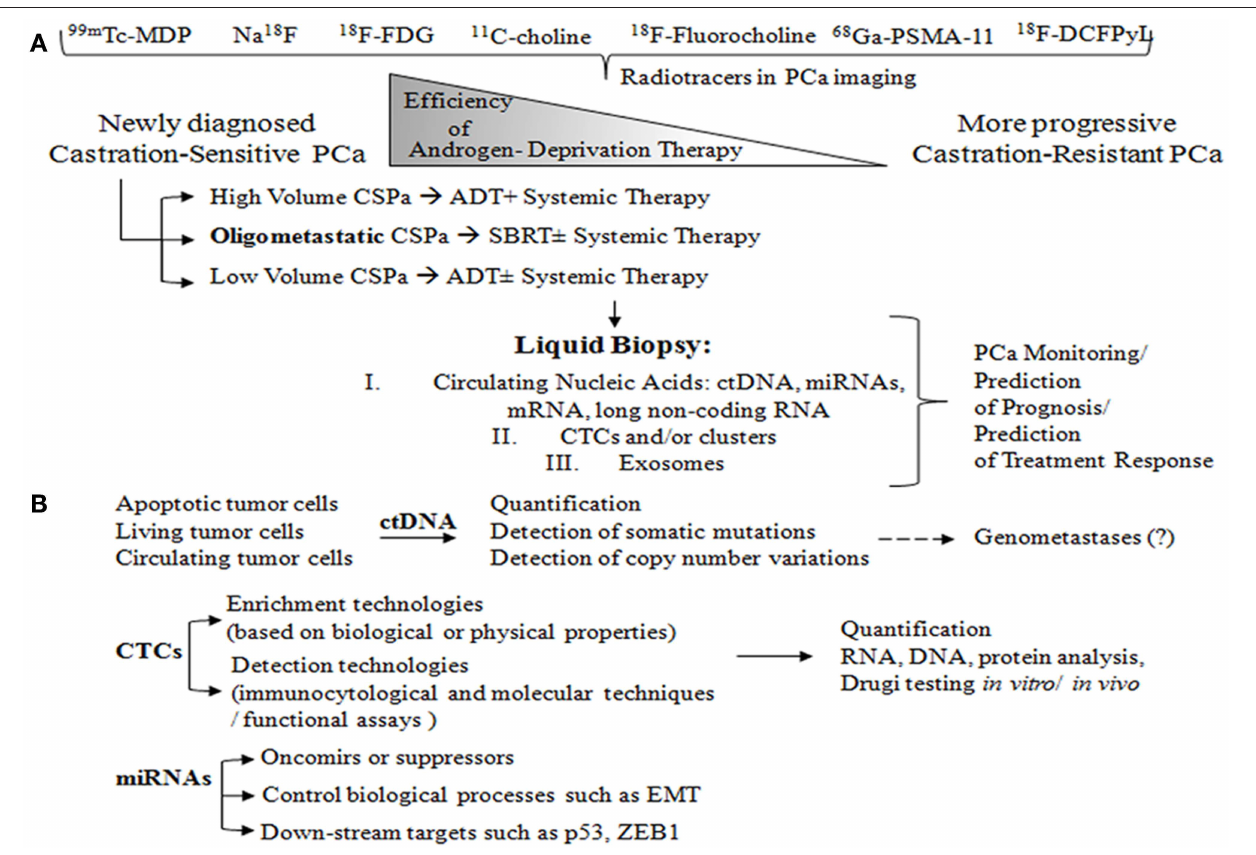
FIGURE 1 | (A) Radiotracers commonly used for imaging in patients with oligometastatic PCa: 99m Tc-MDP and Na 18 F, for imaging bones with altered osteogenic activity; 18 F-FDG, to evaluate abnormal glucose metabolism; 11 C-choline and 18 F-Fluorocholine, both derivatives of choline, which serve to detect metabolically active cells; 68 Ga-PSMA-11 and 18 F-DCFPyL, small molecule inhibitors of PSMA. PCa is characterized by the group of heterogeneous cells that are generally hormone-sensitive but can become castration-resistant. Administration of androgen-deprivation therapy (ADT) promotes the growth of castration-resistant cells, ultimately leading to the formation of castration-resistant PCa. Metastatic volume and distribution influence the treatment decision in metastatic castration-sensitive PCa (CSPC). High volume CSPC is defined as PCa with the presence of visceral metastases or ≥ 4 bone metastases. Oligometastatic PCa is characterized by 3–5 metastatic lesions. Liquid biopsy is a highly promising, non-invasive approach to monitoring PCa, and can be used for prognosis purposes and to predict treatment response. (B) Circulating tumor cells (ctDNA) arise from different sources: apoptotic cells, living cells, and circulating tumor cells (CTCs). ctDNA can undergo several different analyses including quantification, detection of somatic mutations through sequencing and digital PCR, and detection of copy number variations (array CGH). ctDNA is likely involved in transforming normal cells into tumor cells, thus leading to distant metastases (genometastases hypothesis). CTC liquid biopsy reflects anoikis resistance, epithelial mesenchymal transition (EMT), genomic heterogeneity, phenotypic diversity, homing and metastasis-initiating potential, invasion, and/or intravasation ability. CTC enrichment technologies are based on biological properties such as the expression of positive (EPCAM, N-cadherin, and plastin-3) and negative protein markers (CD45) as well as on physical properties (size, density, deformability and electric charges), which can be assessed through membrane and filtration-based systems, microchips, centrifugation on a Ficoll density gradient, dielectrophoresis, and spiral CTC chips. Then, CTC detection can be performed using a wide range of technologies: immunocytological (membrane and/or intra-cytoplasmic anti-epithelial, anti-mesenchymal, anti-tissue-specific marker, or anti-tumor-associated antibodies), molecular (RNA-based) (liquid bead array multi-parameter RT-quantitative PCR (RT-qPCR), and functional assays ( in vitro cell culture- fluoro-EPISPOT technology and xenotransplantation models). The CTCs may then be subjected to a range of different analyses, including quantification, RNA and DNA-based tests, drug testing in vitro (organoids, 3D cultures), and drug testing in vivo (patient-derived xenografts). Interest in microRNAs, which can be